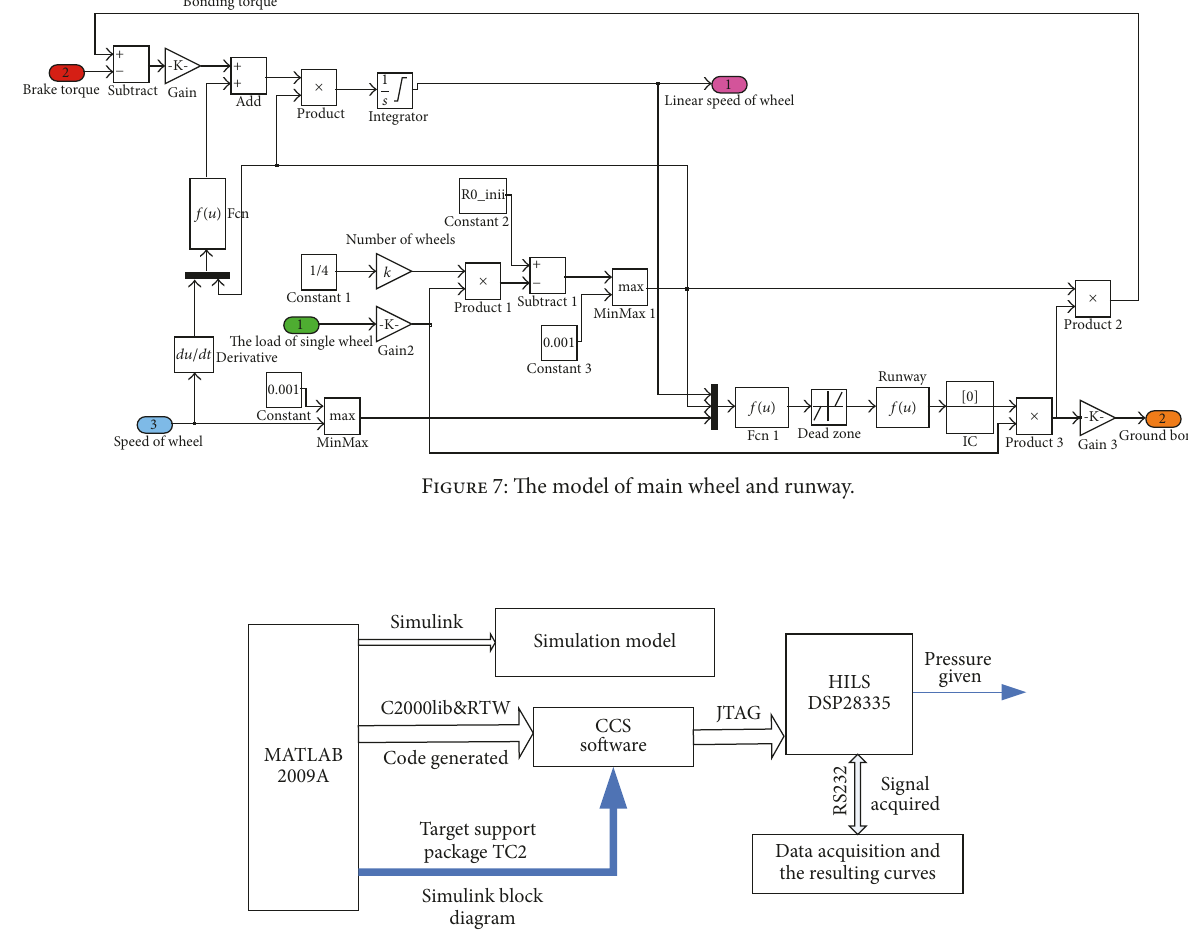
Figure 8: The structure of HILS